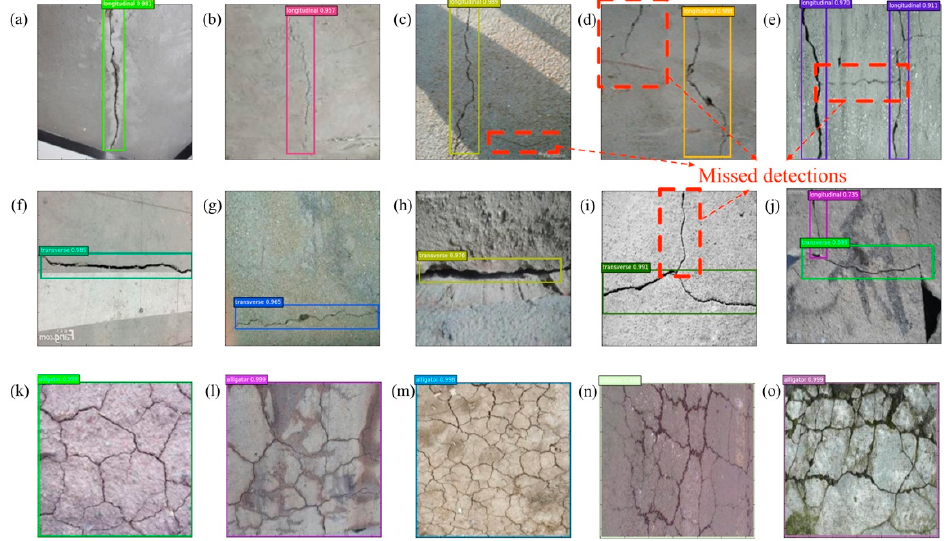
Figure 14. Examples of testing results from three detectors under their optimal configurations. (alligator: k – o ; longitudinal: a – e ; transverse: f – j . The missed detections are highlighted with frames by red dashed line).